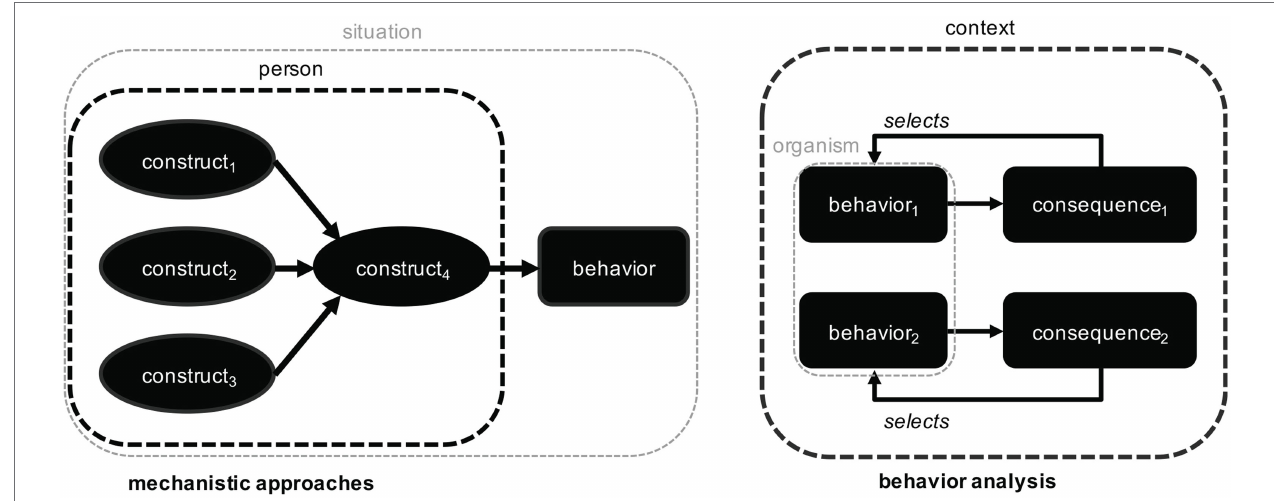
FIGURE 2 | Comparison between mechanistic approaches and behavior analysis. Mechanistic approaches to explaining pro-environmental behavior (on the left, with a focus on mental processes within an individual) is contrasted with behavior analysis (on the right, with a focus on behavior-consequence relationships in